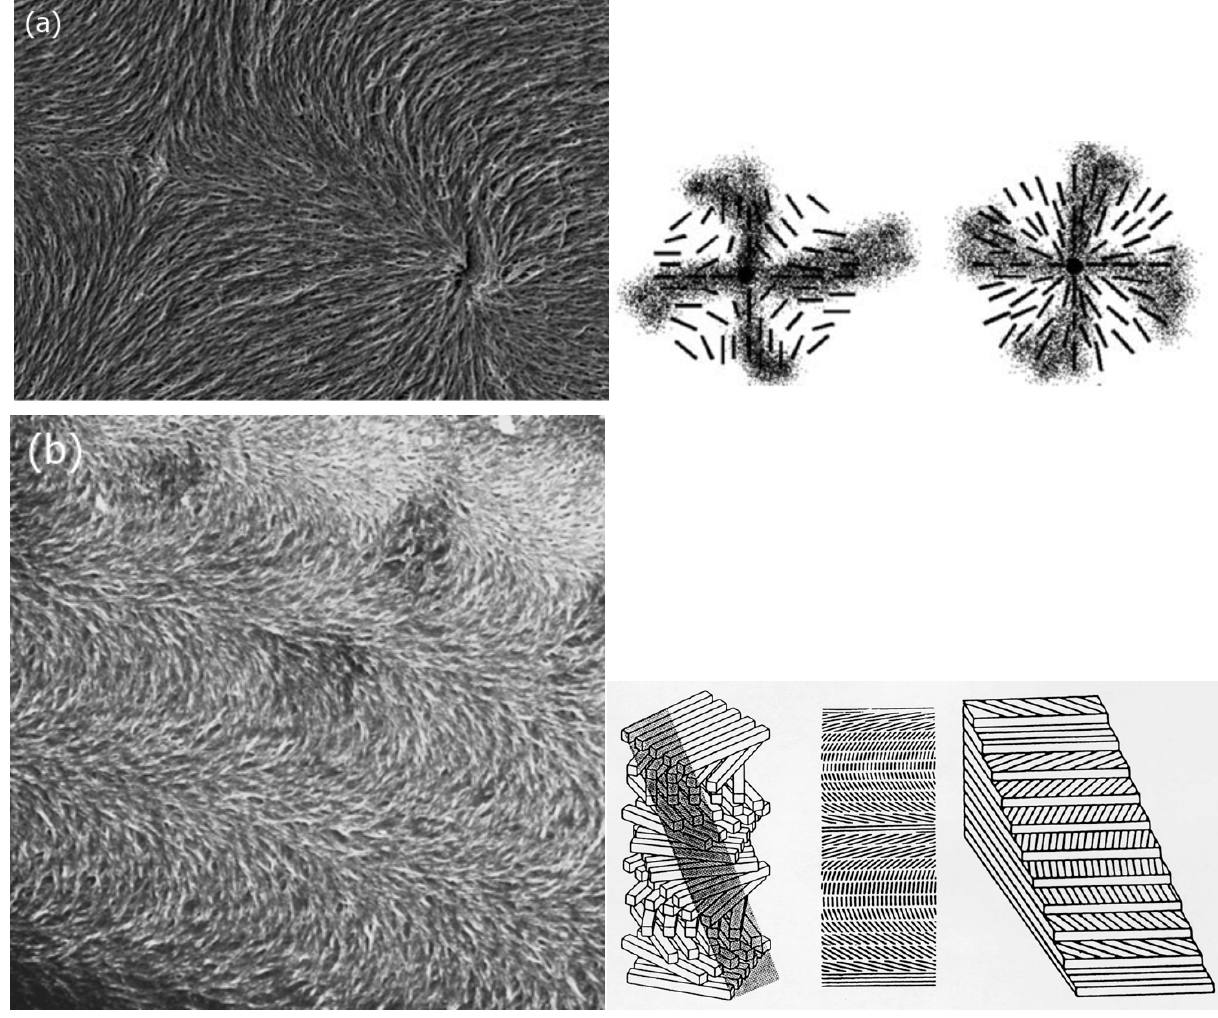
Figure 5. Exemplary scanning electron microscopy (SEM) images of polymer networks formed in different liquid crystalline phases: ( a ) nematic s = ±1 defect pair ( top ) and schematic director field ( bottom ); image side length  50 μ m (Reproduced with permission from [35]. Copyright 2013 Royal Society of Chemistry); ( b ) helical superstructure of the chiral nematic, N* phase ( top ), which can be illustrated by an oblique cut called a Bouligand cut ( bottom ); image side length  50 μ m (Reproduced with permission from [33]. Copyright 1997 American Physical Society); ( c ) different director orientation in SmA* twist grain boundary (TGB) blocks ( top ) and schematic representation ( bottom ); image side length  5 μ m. (Reproduced with permission from [36]. Copyright 2009 Royal Society of Chemistry) and ( d ) well oriented SmA phase ( left ) and close-up ( right ); image side length  5 μ m. The material used is the well known RM257 from Merck, and the liquid crystal has been removed by a suitable solvent after polymerization. For the SEM investigations the polymer network was then coated with a very thin layer of